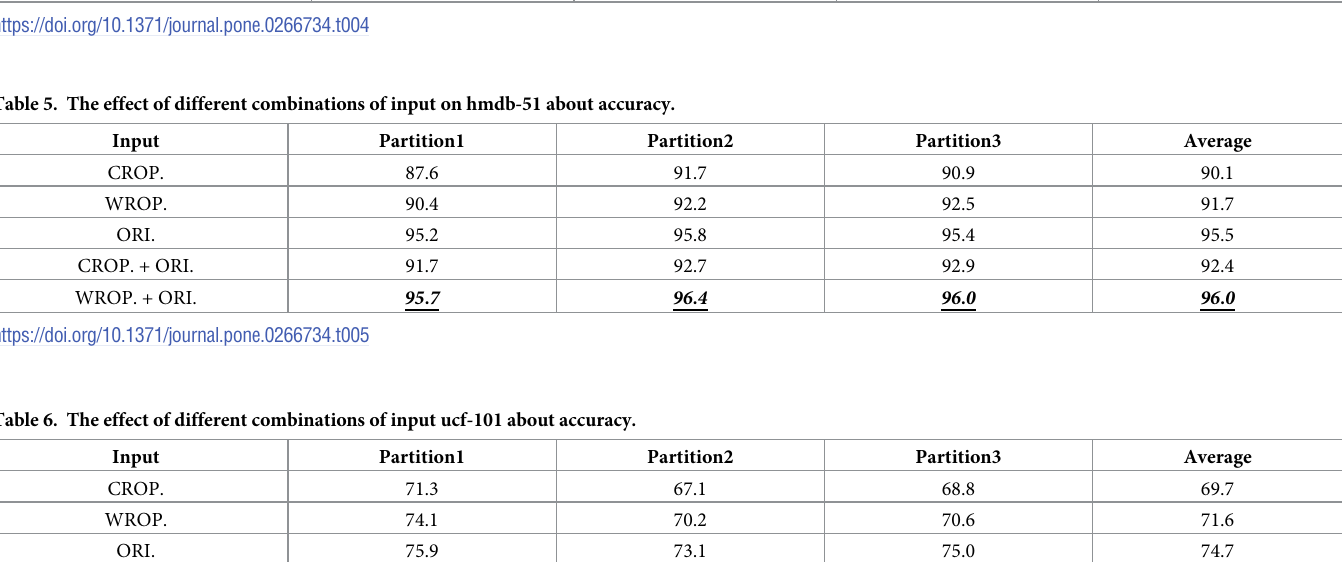
Table 4. The effect of different combinations of α and γ on ucf-101 about accuracy. α = 0.50 & γ = 0.50 α = 0.50 & γ = 0.75 α = 0.50 & γ = 2.00 α = 0.50 & γ = 5.00 α = 0.75 & γ = 3.00 α = 0.75 & γ = 5.00 α = 0.90 & γ = 10.0